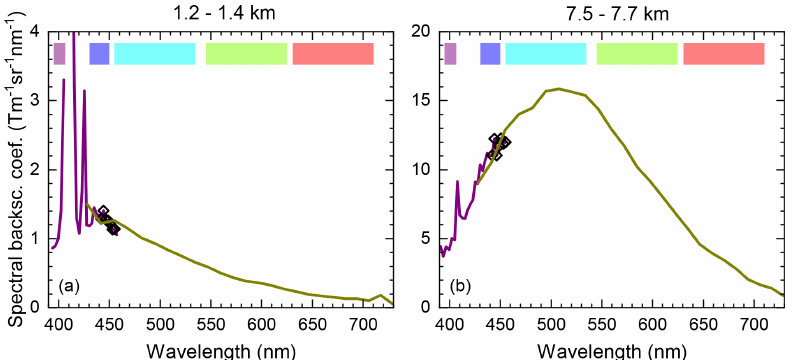
Figure 4. Determination of the calibration coefficient as exemplified by the RAMSES measurements at (a) 1.2–1.4km and (b) 7.5–7.7km on 22 August 2021 at 01:30UTC. The relative-calibrated spectra obtained with the VIS spectrometer (dark yellow curves) are fitted to the absolute-calibrated spectra of the UVA spectrometer (violet curves) over the wavelength range 441–456nm (center wavelengths of UVA spectrometer detection channels indicated by black symbols); the calibration coefficients obtained are (a) 0.2213 and (b) 0.2312. Pastel violet, blue, cyan, green, and red color bars show spectral integration ranges (395–407, 430–450, 455–535, 545–620, and 630–710nm, respectively) of false color parameters of the aerosol fluorescence